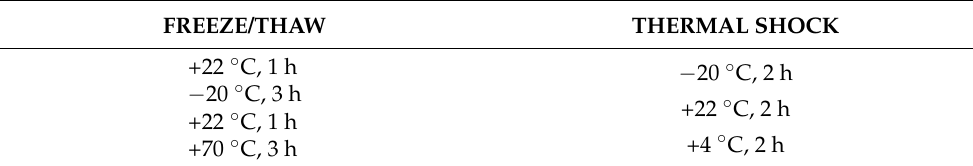
Table 1. Accelerated aging program freeze/thaw and thermal